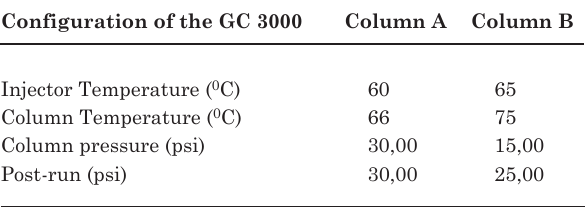
table 2. Chromatograph operating conditions (column a = molsieve 5a, column B = plot u)